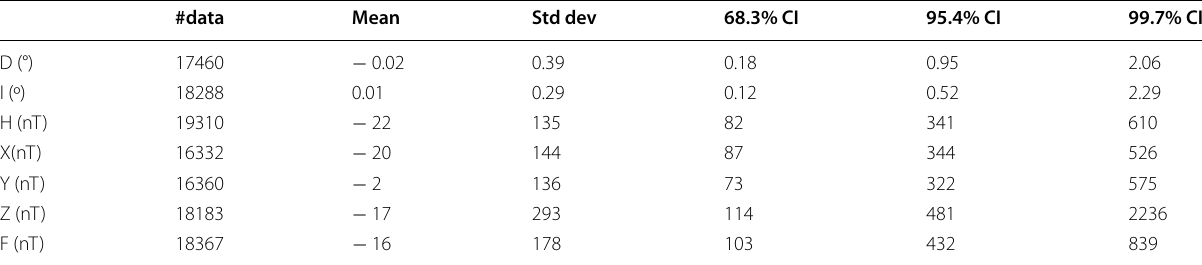
Table 1 Mean, standard deviation and the 68.3%, 95.4% and 99.7% confidence intervals (CI) of the residuals for each magnetic component